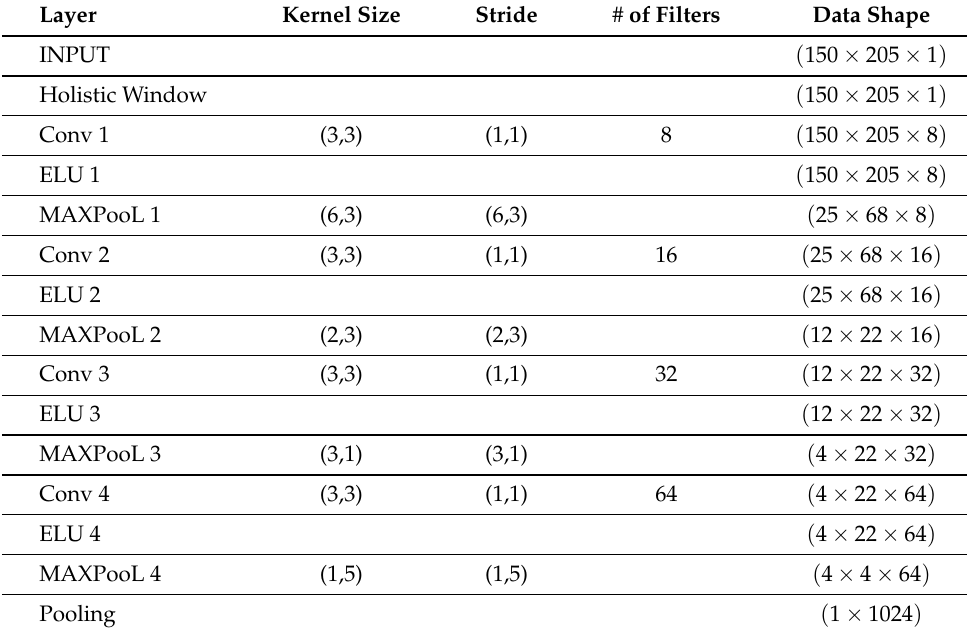
Table 2. Window Encoder Specifications for Holistic Window